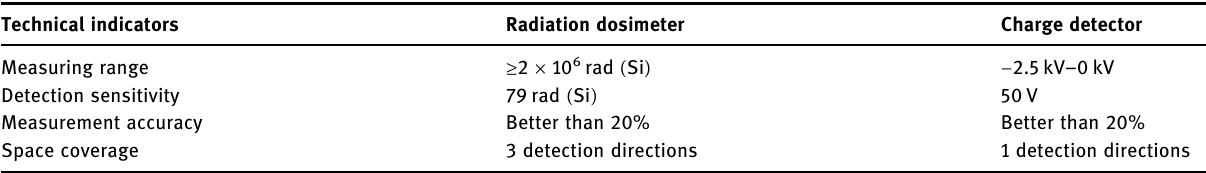
Table 1: Main technical indexes of detectors Technical